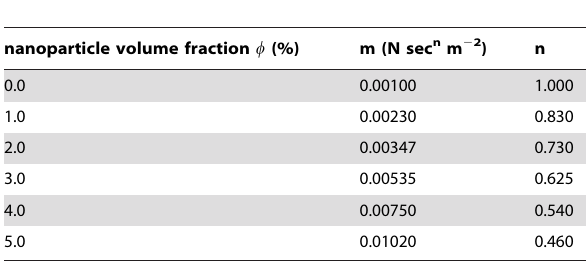
Table 1. Values of the fluid consistency coefficient m and flow behavior index n for different w [13,14].